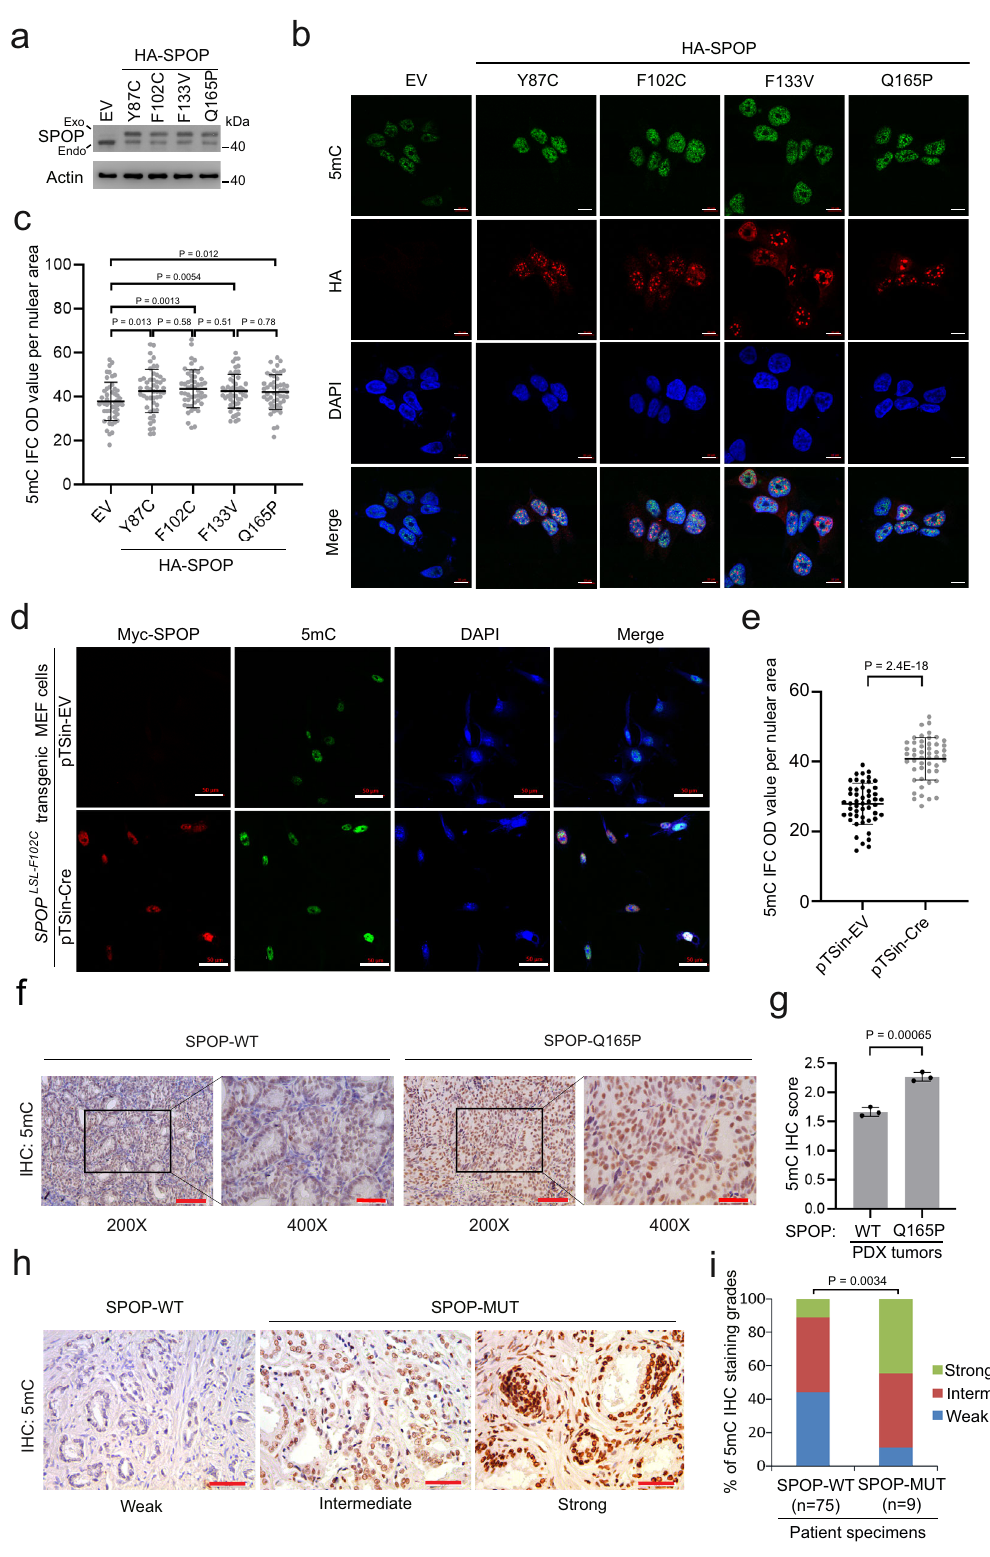
(Supplementary Fig. 1i). These results rule out the possibility that SPOP regulates DNA methylation by directly binding or mod- ulating the expression of DNMT proteins in PCa cells. To de fi ne in an unbiased manner the molecular mechanisms by which SPOP mutations regulate DNA methylation, we